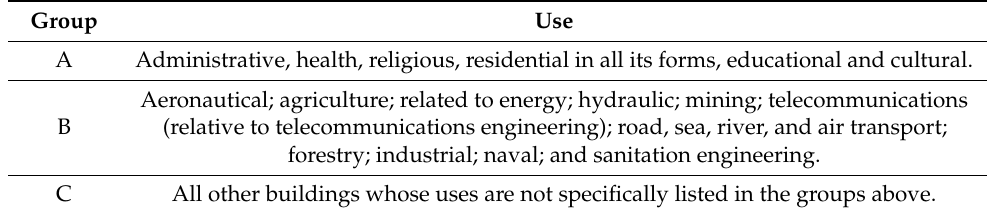
Table 5. Summary of the building agents, functions, and professional prerequisites according to the LOE [14]. Building Agents per